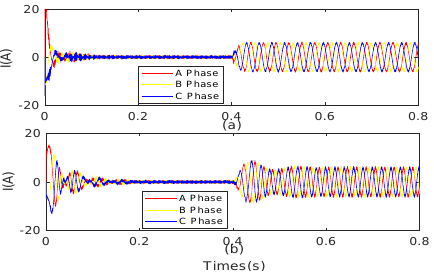
Figure 21. The estimation of rotor position Angle using PI. ( a ) Observed and actual rotor position Angle. ( b ) Rotor position Angle observation error.